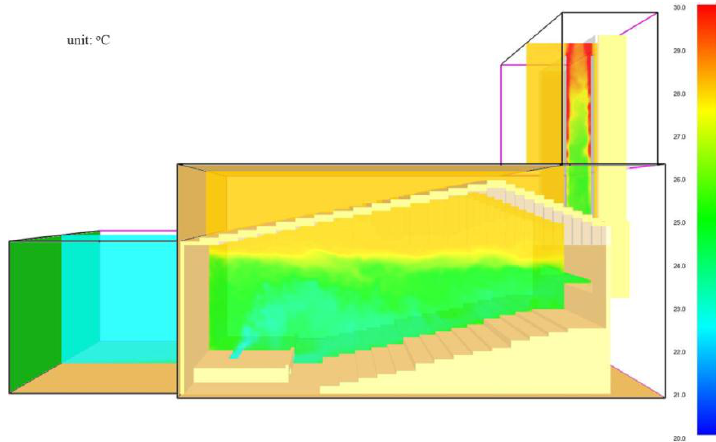
Figure 10. Temperature profile in the normal situation.